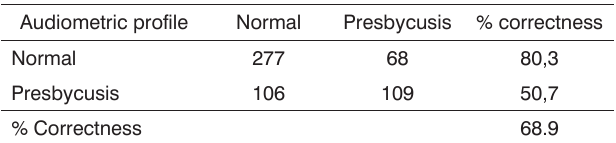
Table 5. Sensitivity and specificity of the inferred